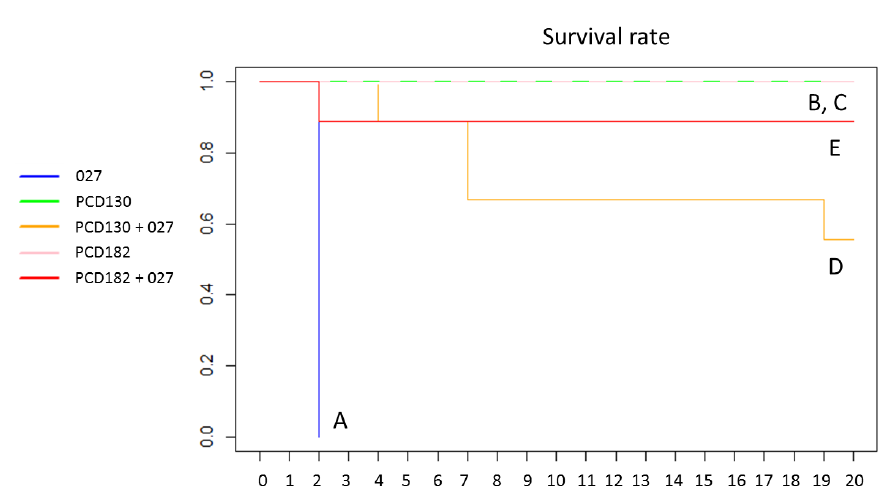
Figure 4. Survival curve of the five hamsters groups over time.